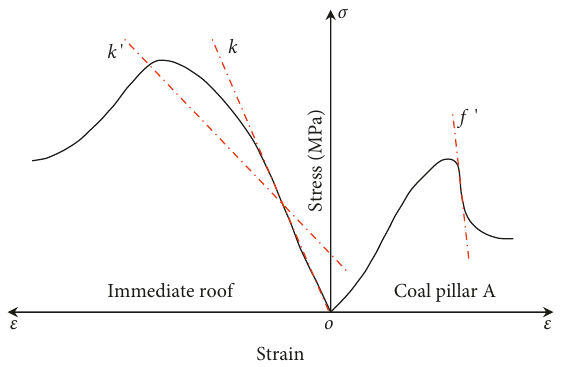
Figure 5: The strain-stress curves of coal-rock mass system when the acceleration of immediate roof movement is not zero.